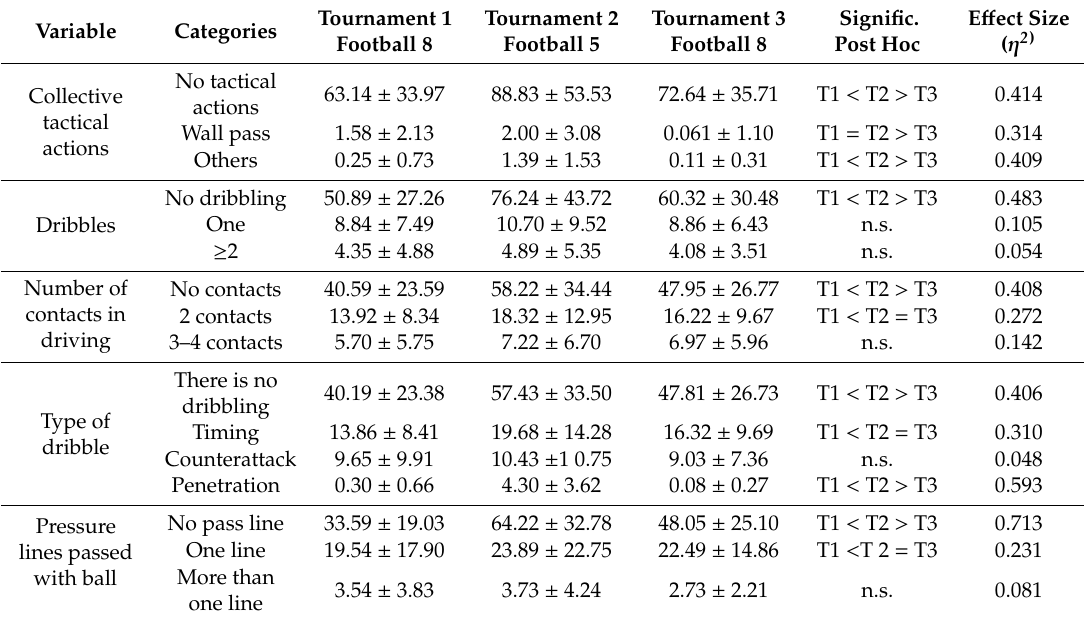
Table 4. Tactical aspects performed by the player with the ball in the development of the